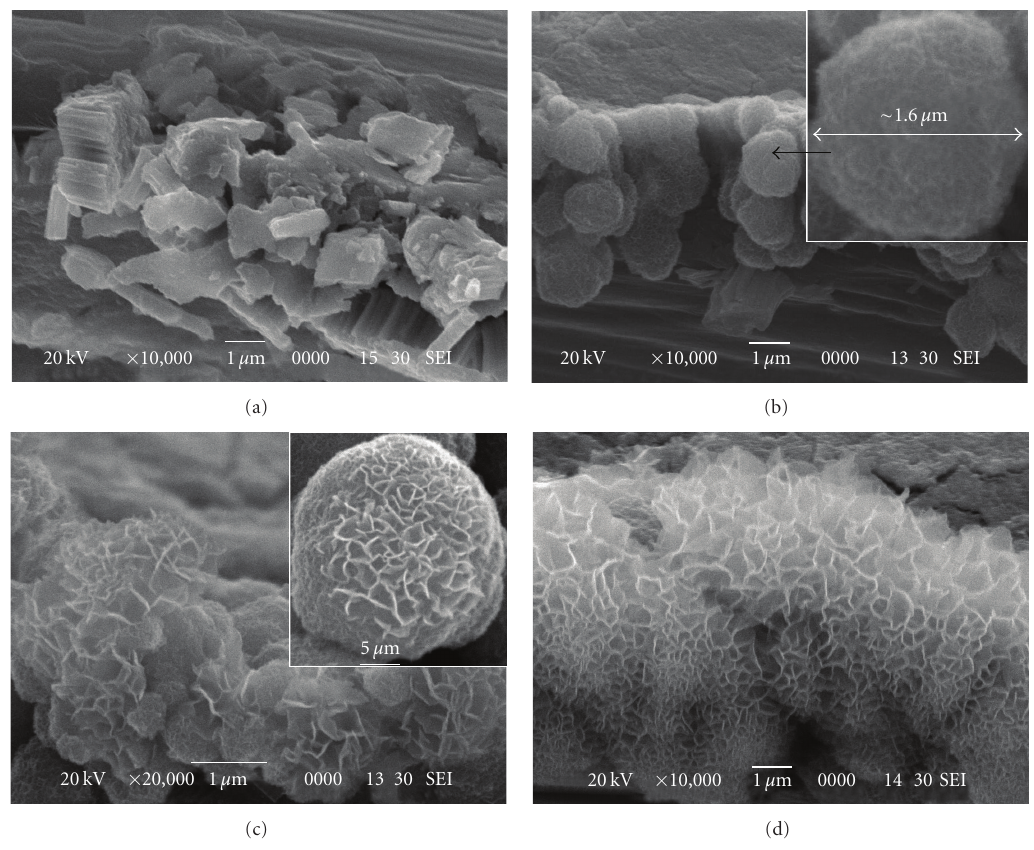
Figure 2: SEM micrographs of MnO 2 thin film after cyclic voltammetric cycling in 0.2M Na 2 SO 4 liquid electrolyte for (a) 0 cycle, (b) 50 cycles (inset shows a spherical microparticle), (c) 100 cycles (inset shows enlarged microparticle with petal-like structure), and (d) 300